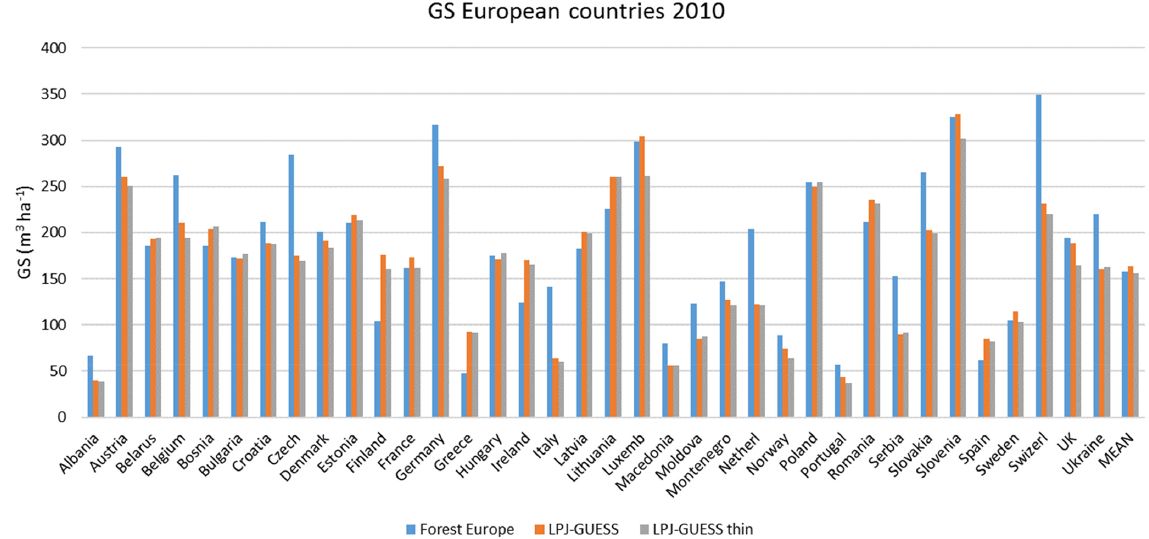
Figure E3. Modelled and observed (Forest Europe, 2015) growing stock (GS) for individual countries in 2010. LPJ-GUESS is the simulation without thinning. LPJ-GUESS thin is the simulation with automated thinning.